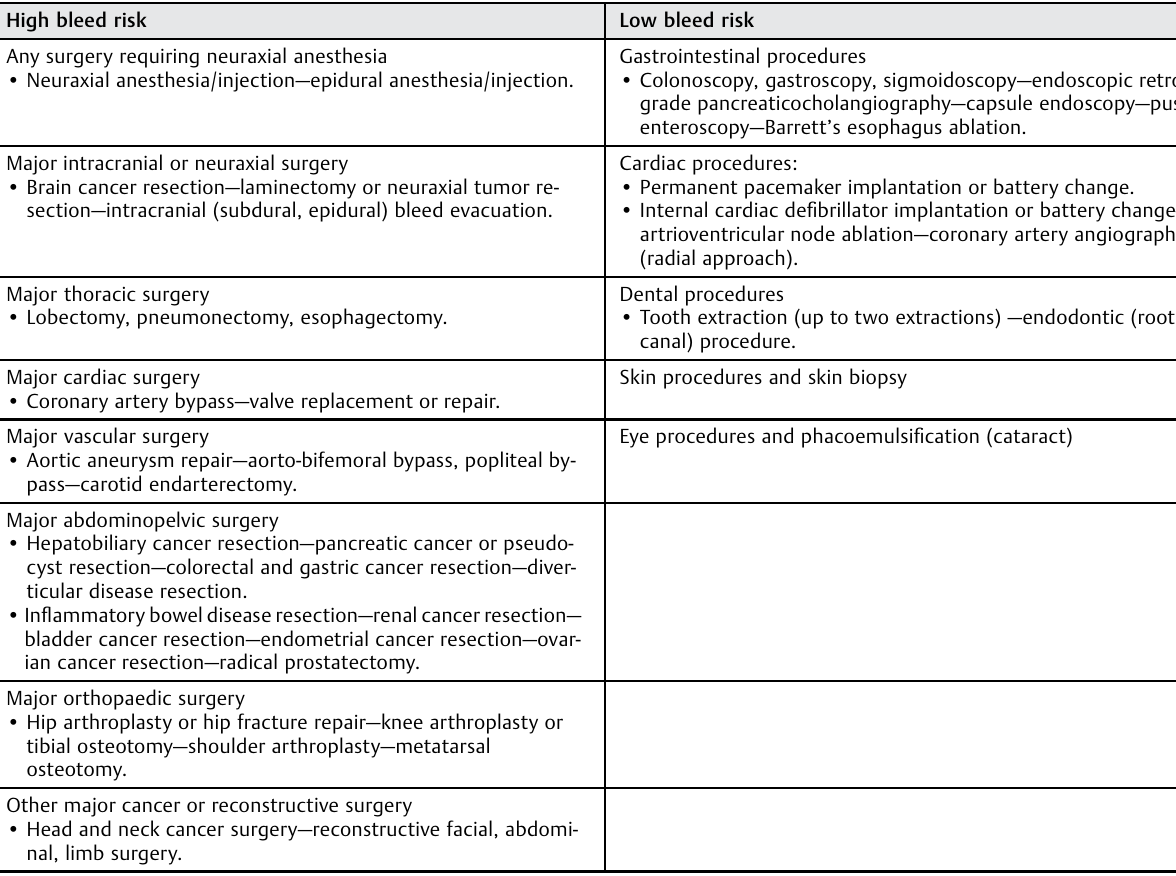
Table 1 Surgery/procedure classi fi cation based on bleed risk High bleed risk Low bleed